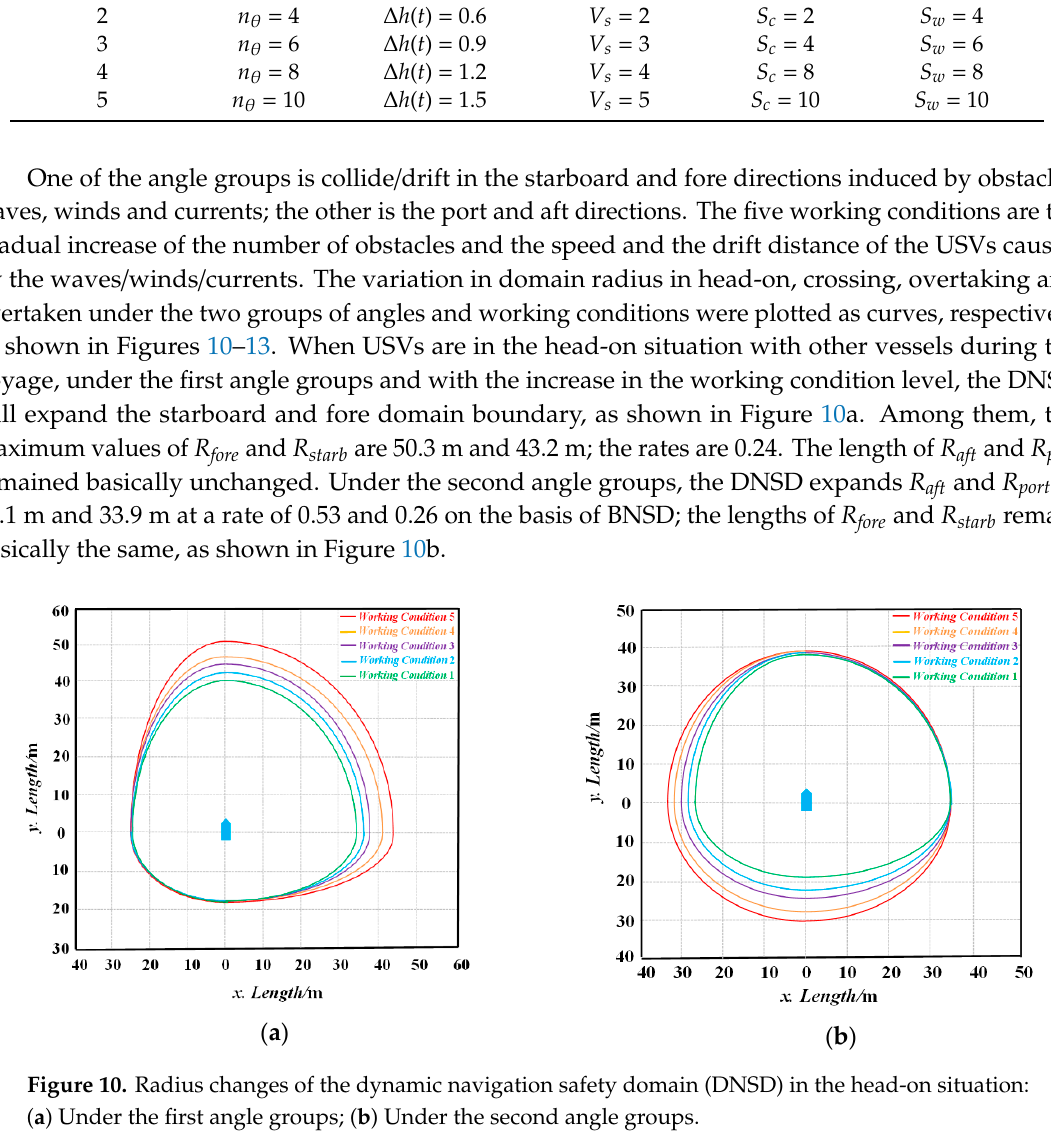
( b ) Figure 11. Radius changes of the DNSD in the crossing situation: ( a ) Under the first angle groups; ( b ) Under the second angle groups. When overtaking other vessels, own USV is the give-way ship and needs to pay close attention to the movements of the stand-on vessels. Under the first angle groups, the R fore and R starb in the DNSD increases to 43.3 m at the rate of 0.29 and 0.24, respectively, as shown in Figure 12a. In the second angle groups, the R aft and R port increase to 30.1 m and 33.9 m at rate of 0.53 and 0.26, as shown in Figure 12b, in which the length of R port is larger than R fore . This is because when ships fulfill the requirements of the COLREGs, the majority of overtaking vessels usually overtake from the starboard of the overtaken ships. When drifting to the stand-on ships under the influence of various factors, the DNSD can expand the port and aft boundaries to make own USV avoid a collision earlier.